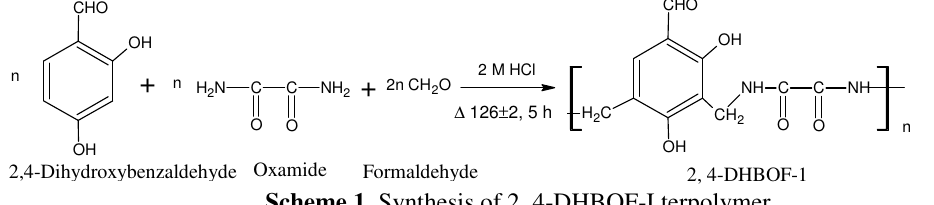
Table 1 . Synthesis and physical data of 2, 4-DHBOF terpolymers resins.